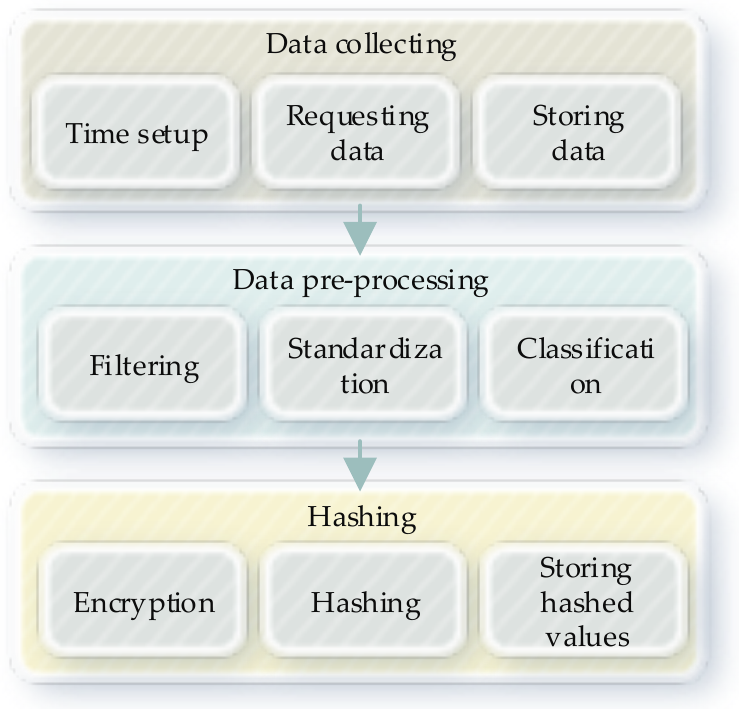
Figure 7. Gateway data management based on blockchain framework.